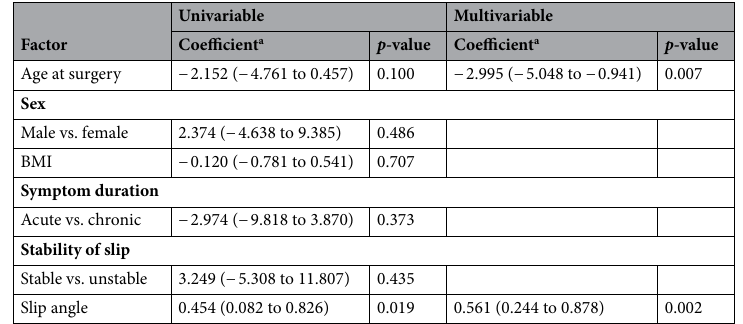
Table 4. Linear regression analysis of leg length discrepancy in patients with moderate slip. CI confidence interval. a The values are given as coefficients with the 95% CI in parentheses.